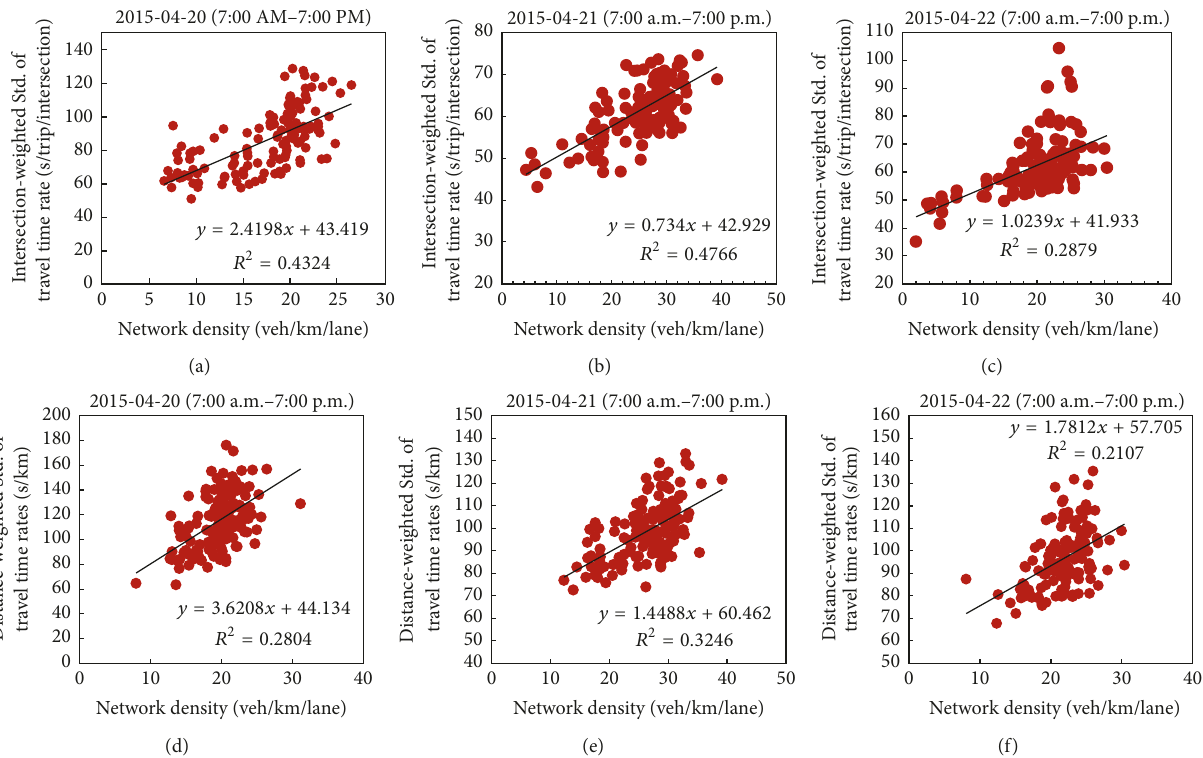
Figure 8: Weighted standard deviation of travel time rate versus network